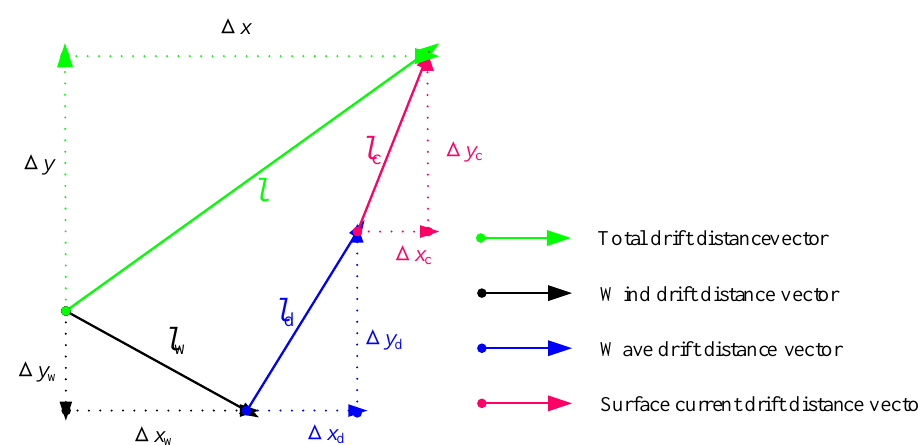
Figure 2. The drift distances and components induced by the wind, waves and surface currents.